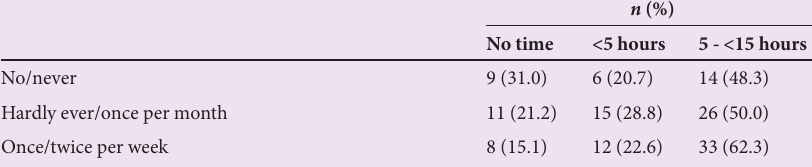
Table 6. Regularity of participation v. time for education in religion